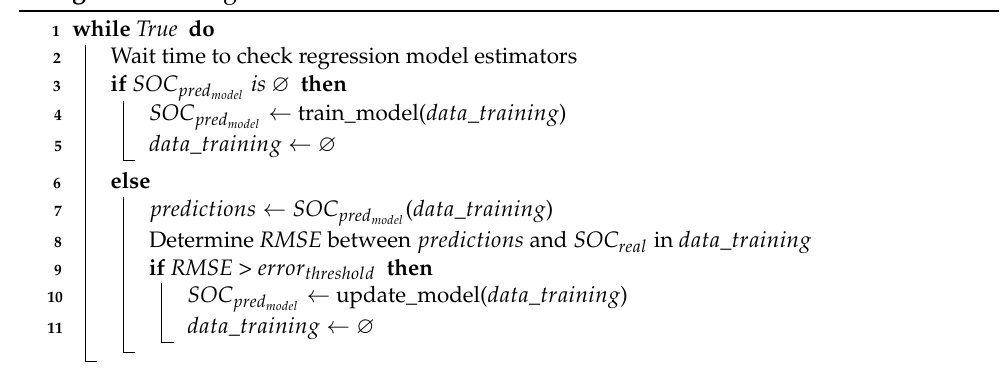
Algorithm 4: Regression Model